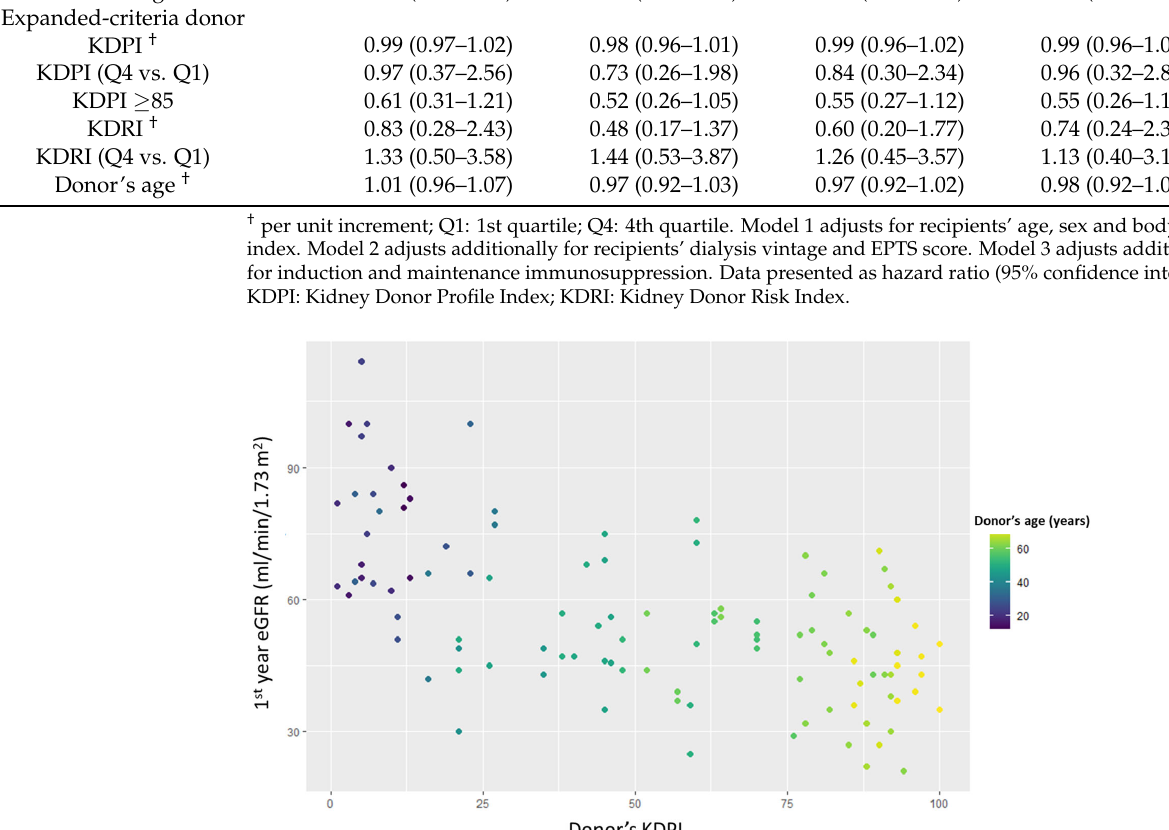
Figure A1. Scatterplot of 1st year-estimated glomerular filtration rate and donor’s KDPI among Figure A1. Sca tt erplot of 1st year-estimated glomerular fi ltration rate and donor’s KDPI among re- recipient pairs transplanted from the same cipient pairs transplanted from the same donor.